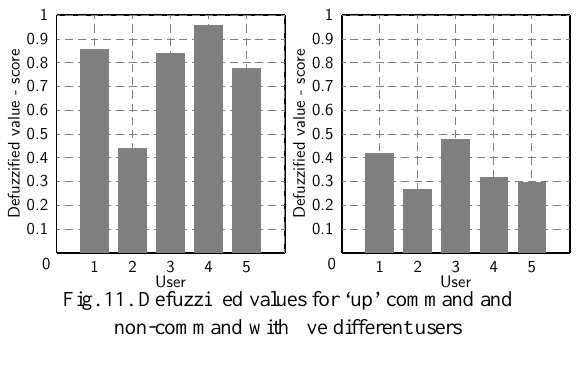
Fig. 9. Display for the feedback